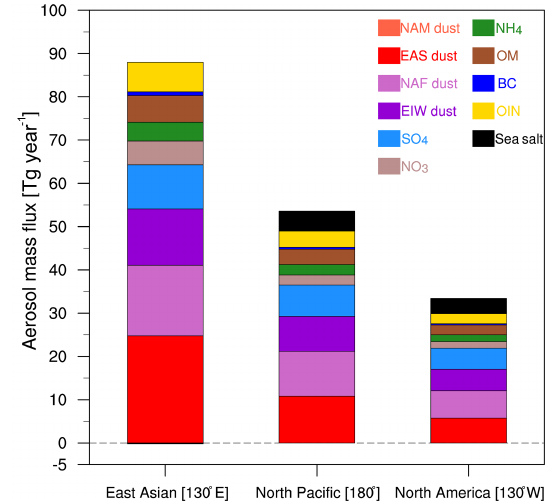
Figure 8. Model-based estimate of aerosol annual mass flux in East Asian outflow, across the North Pacific and North America inflow from the WRF-Chem simulation averaged for